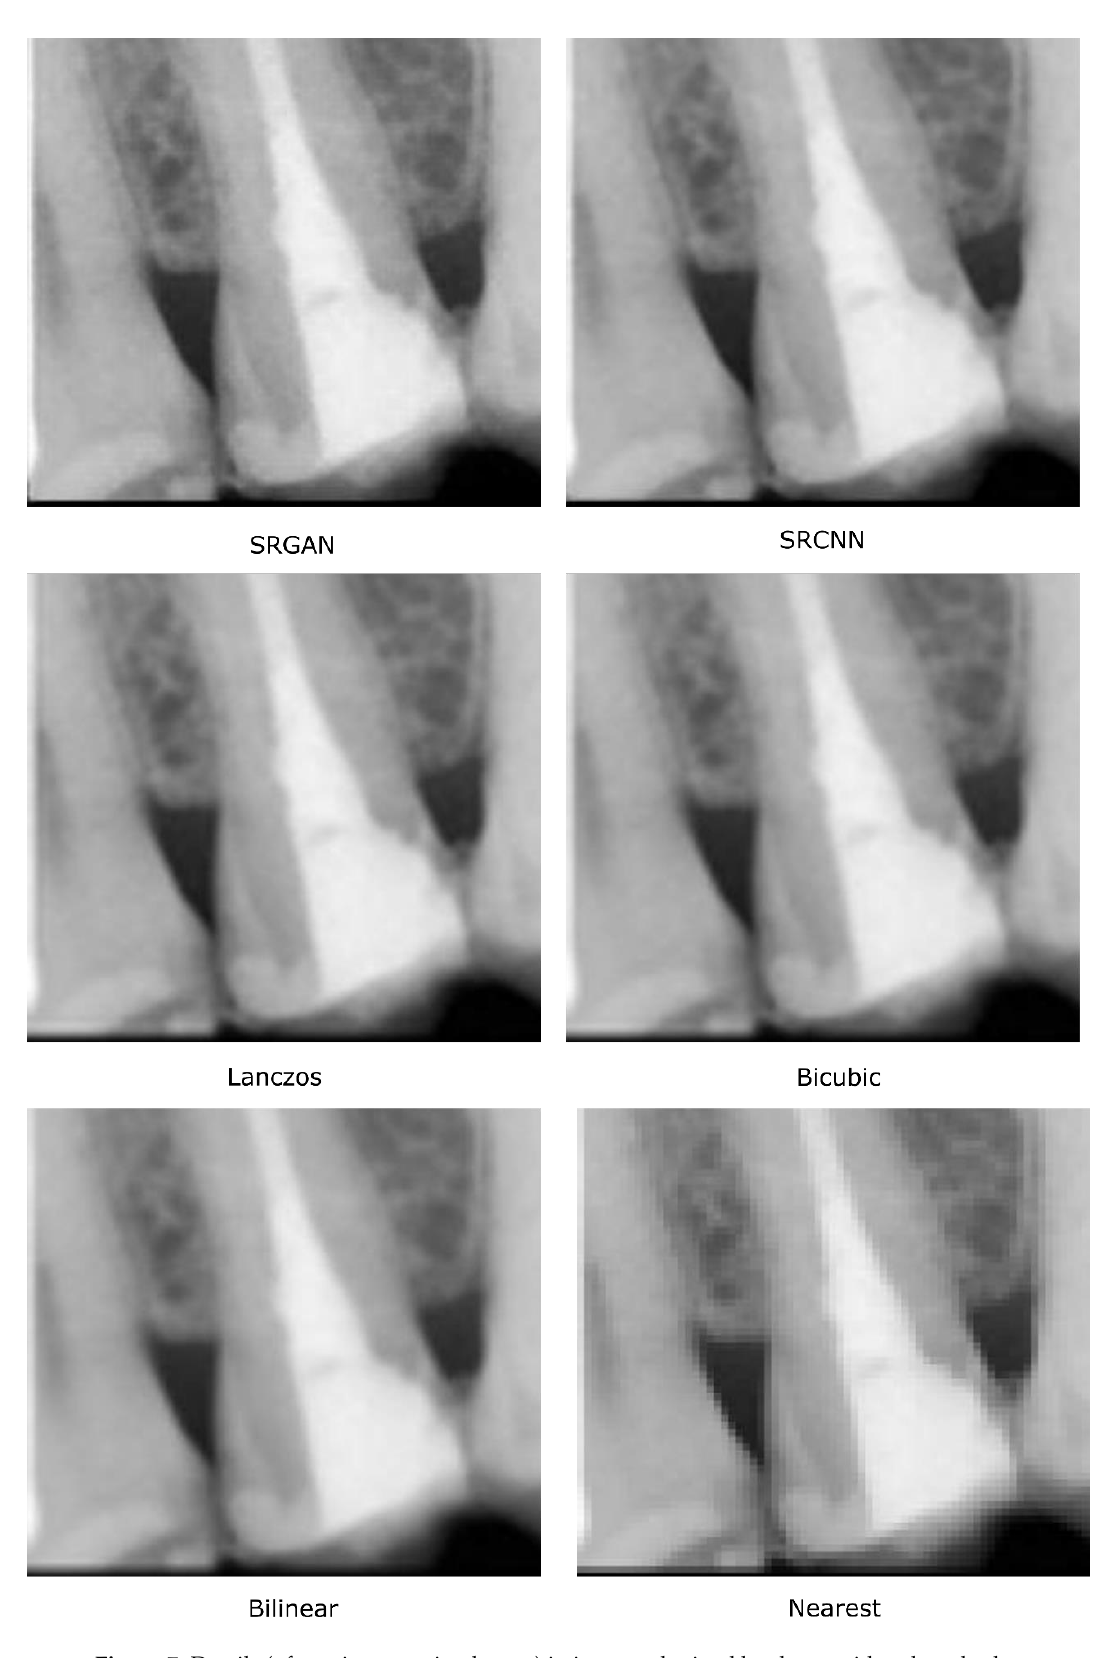
Figure 7. Details (of two interproximal areas) in images obtained by the considered methods. Even considering that in Study 2 we focused on a classification task, using a pre- processing step that improves the spatial resolution of input images is interesting for a